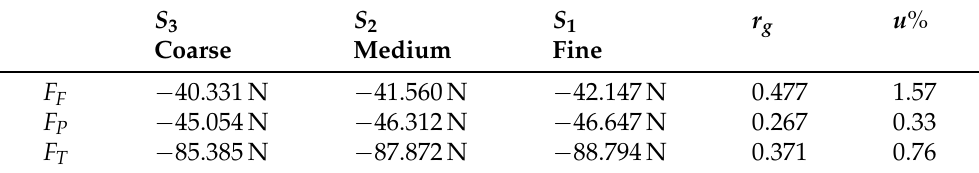
Figure 15. Grid dependency for RANS simulations. Table 5. Results of grid convergence study for three grids with 3.7 million ( S 1 ), 1.5 million ( S 2 ) and 460,000 cells ( S 3 ) for one